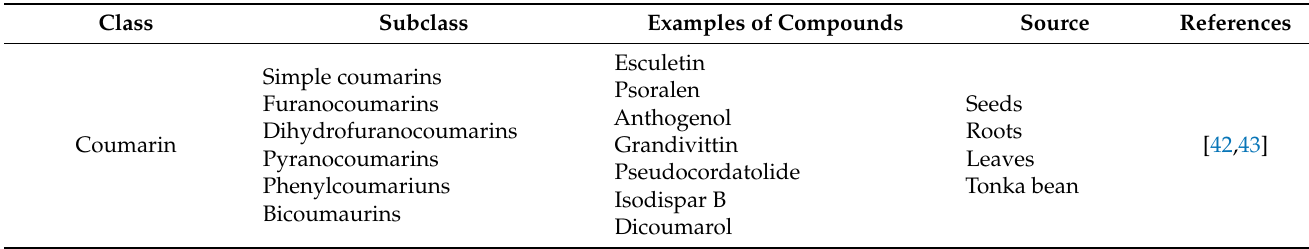
Table 1. The classification of polyphenols was adapted after Wici´nski et al. [40].